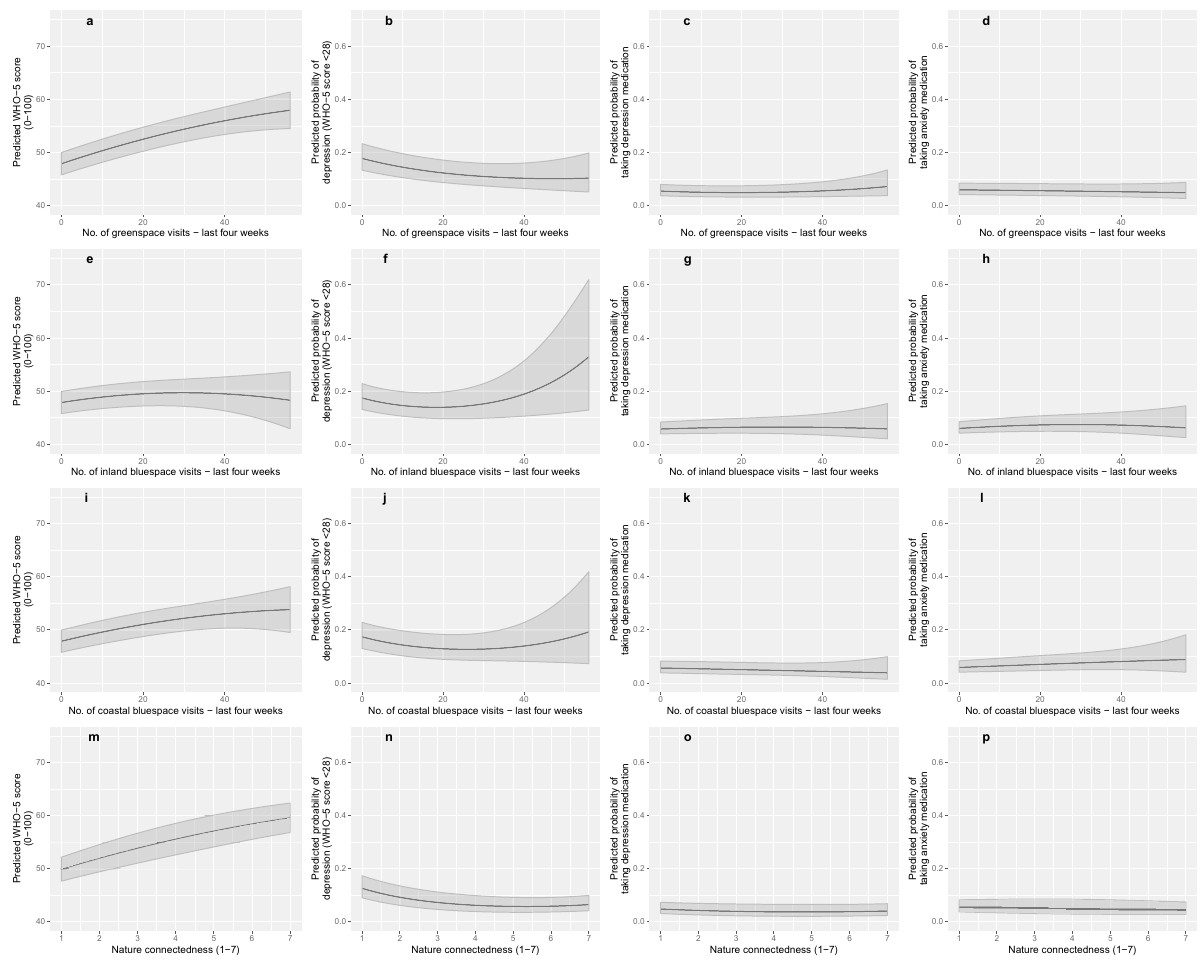
Figure 1. Relationships between: (1) Green space visits in last 4 weeks, (2) Inland-blue space visits in last 4 weeks, (3) Coastal-blue space visits in last 4 weeks, and (4) nature connectedness (1–7); and positive well- being (0–100; a,e,l,m ), risk of mental distress (0–1; b,f,j,n ), use of depression medication (0–1; c,g,k,o ), and use of anxiety medication (0–1; d,h,l,p ), averaged across 18 countries (n = 16,302). Plots are based on predicted values from linear and logistic mixed effects regression models including linear and quadratic terms (with 95% Confidence Intervals) for visit frequency and connectedness controlling for residential exposure, visit frequencies to alternative locations, connectedness ( a – l only), age, gender, employment status, relationship status, household income, longstanding-illness, education level, household composition, dog ownership, car ownership, physical activity, season (sample wave), and country (as a random effect). Depression models also control for anxiety medication use and vice versa. Visit frequency was capped at n = 56 (i.e. two visits per day over 4 weeks). Covariates are held constant at their reference categories, or at their means for continuous